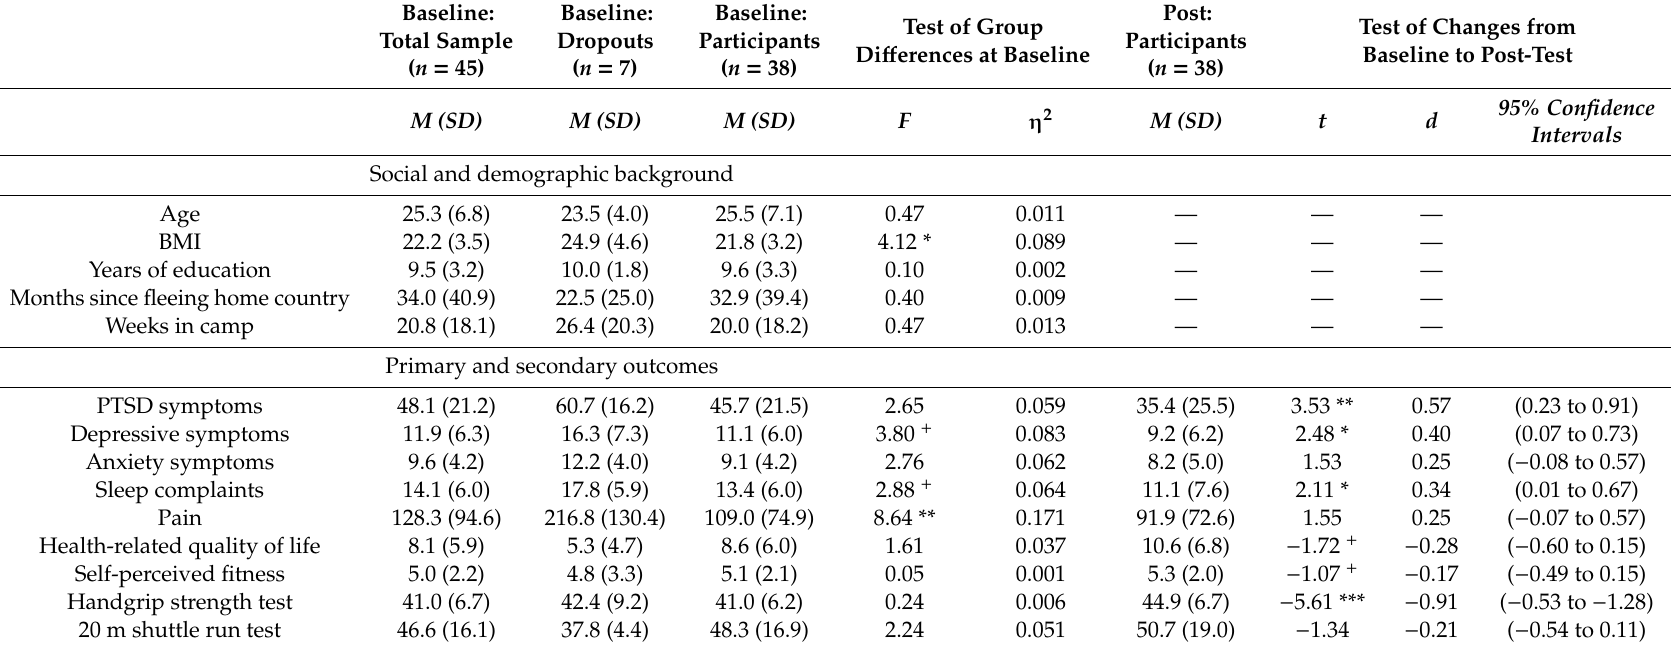
Table 1. Group di ff erences in socio-demographic background between dropouts and refugees who participated in both data assessments at baseline, and post-test scores of